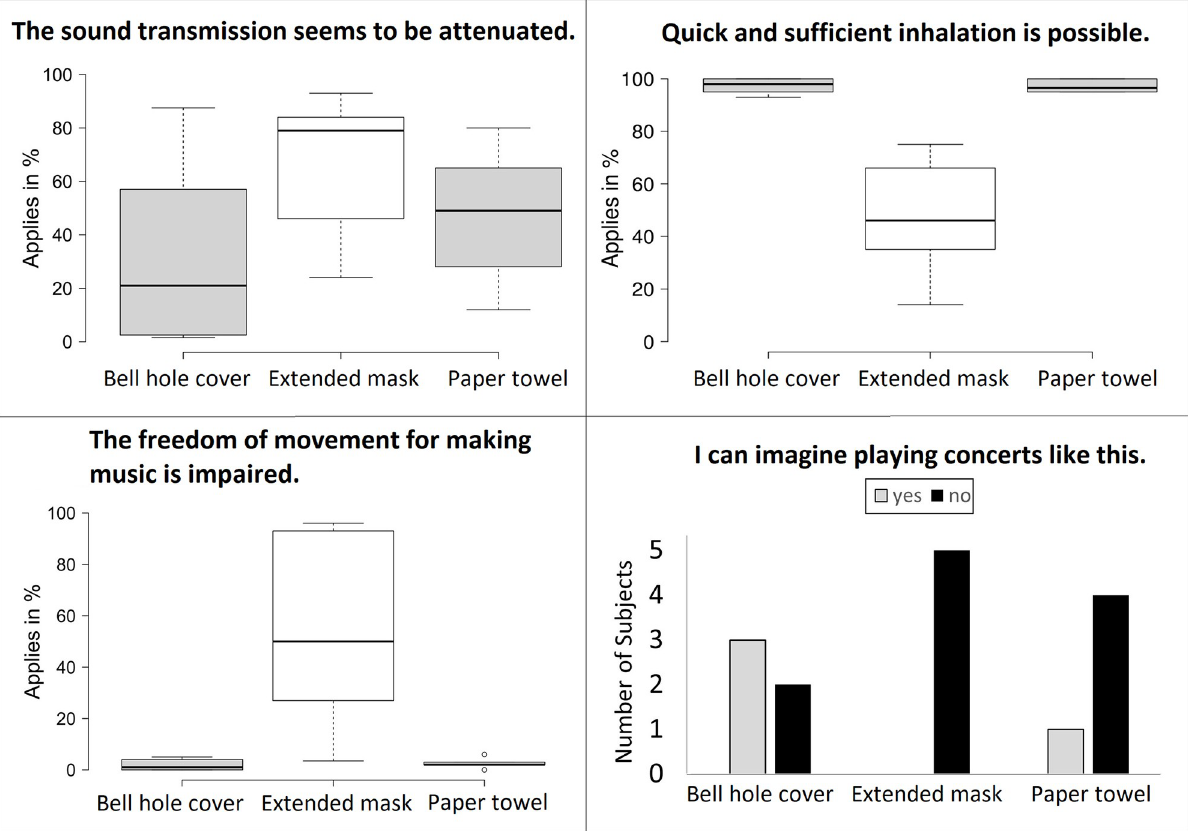
Fig 6. The subjects’ evaluation of the practicability of the potential safety procedures. The results were obtained from a questionnaire (see S1 File) with visual analogue scales.